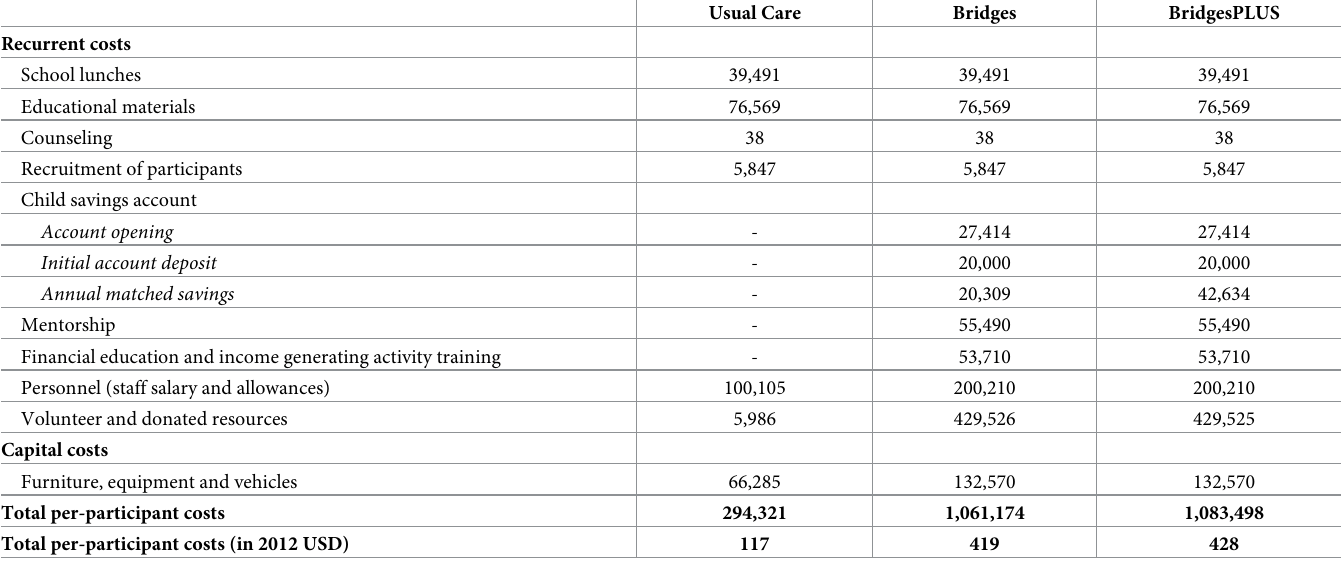
Table 1. Itemized total per-participant costs (all costs are in 2012 Ugandan Shillings unless otherwise